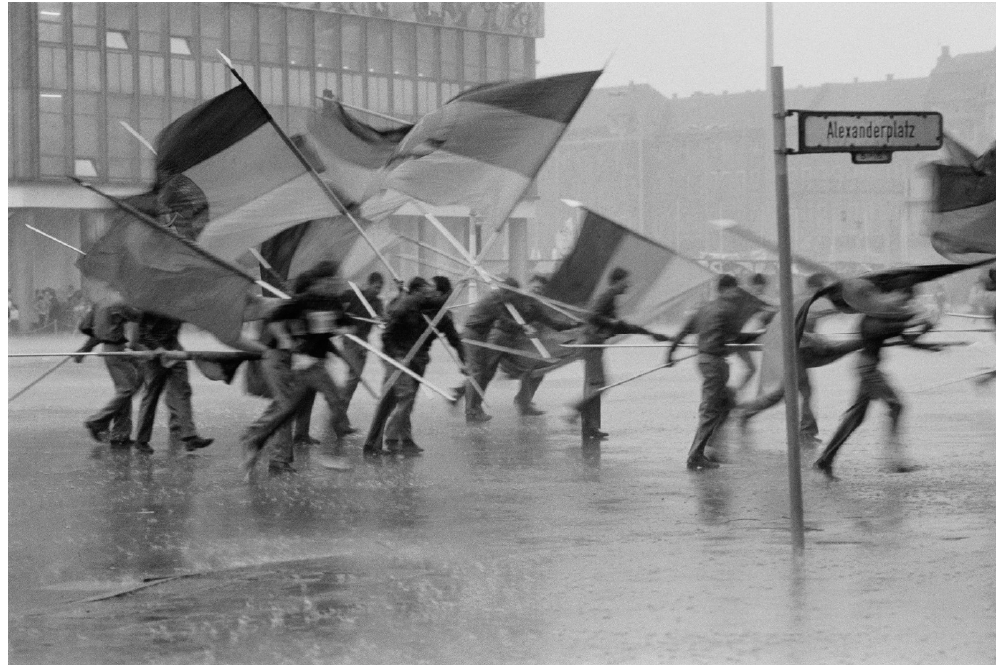
Figure 4. Harald Hauswald, ‘Fahnenflucht’, 1. Mai Demonstration auf dem Alexanderplatz (‘Desertion’, May Day March at Alexanderplatz), 1987. Photo Credits: Ostkreuz–Agentur der Fotografen/Harald Hauswald.